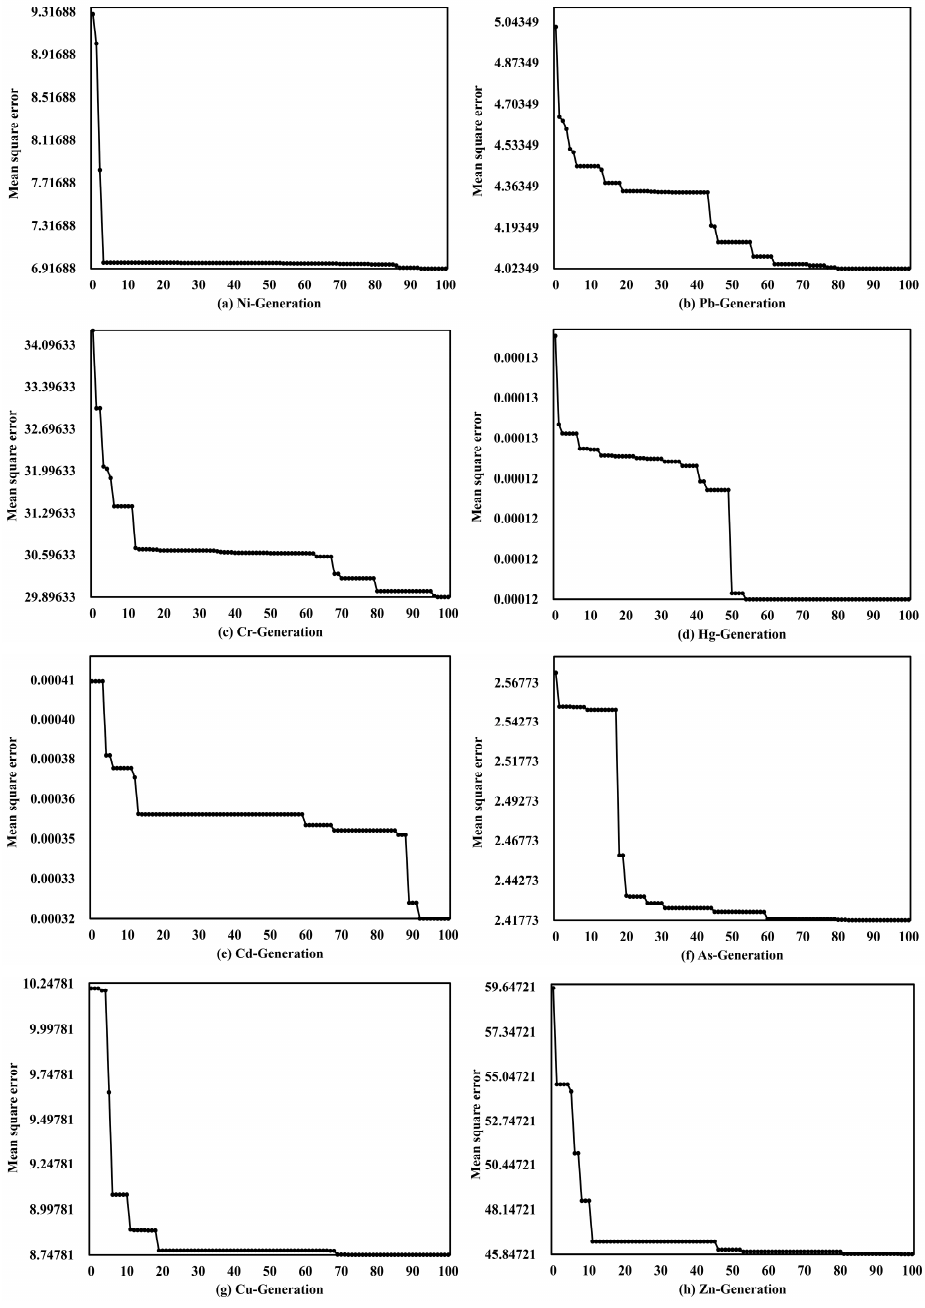
Figure 3. GA parameter optimization process (( a – h ) correspond to the elements of Ni, Pb, Cr, Hg, Cd, As, Cu and Zn, respectively).